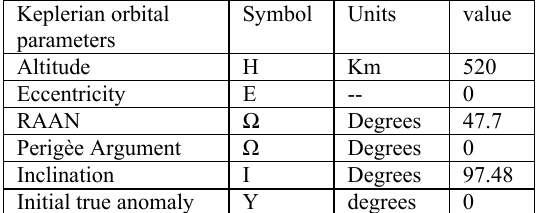
Table A2 ESEO orbital parameters